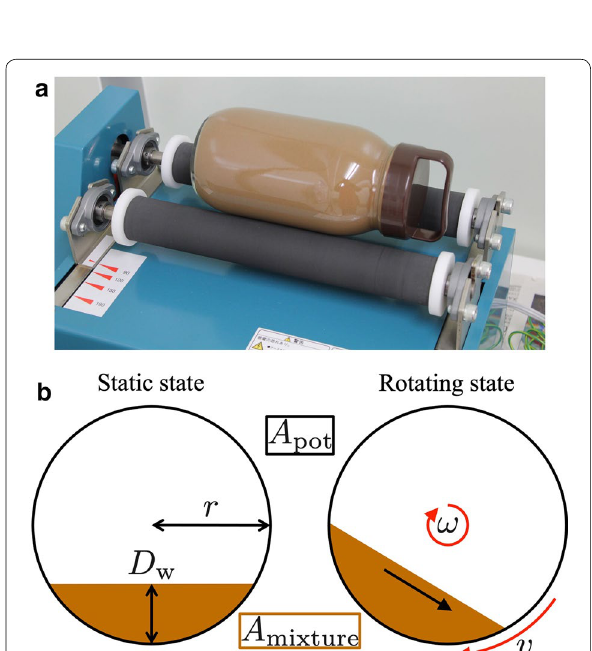
Fig. 1 Mixing experimental system: a photograph and b schematic images of circular cross-section. The system used to rotate the capped cylindrical glass pot containing tephra, water, and snow. The pot is automatically rotated on the rotating table (NITTO KAGAKU, ANZ-51D) at a constant